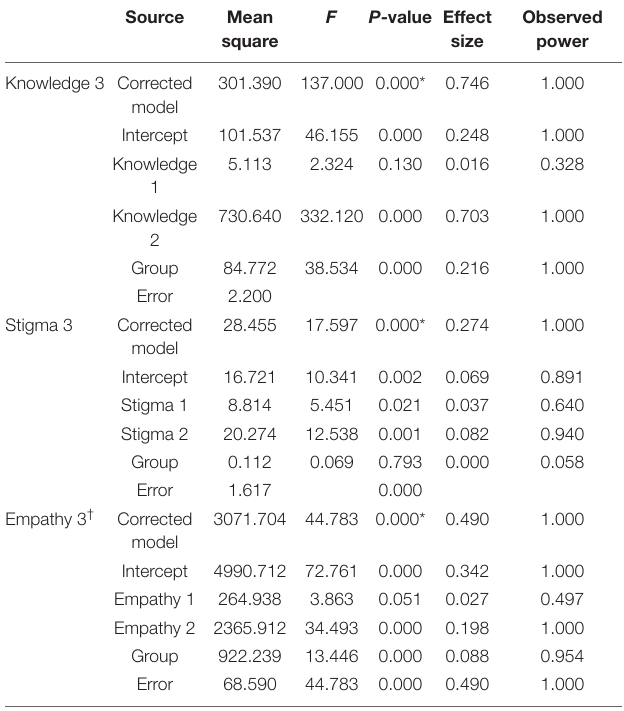
TABLE 3 | Univariate analysis of covariates for the assessments.